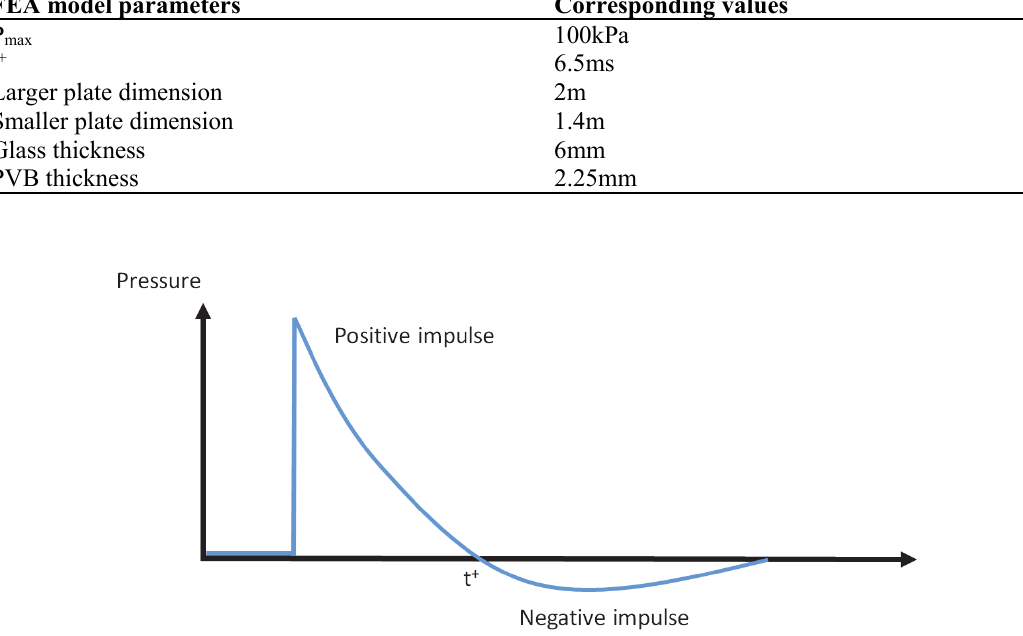
Fig. 4: illustration of the Friedlander waveform used to simulate a blast